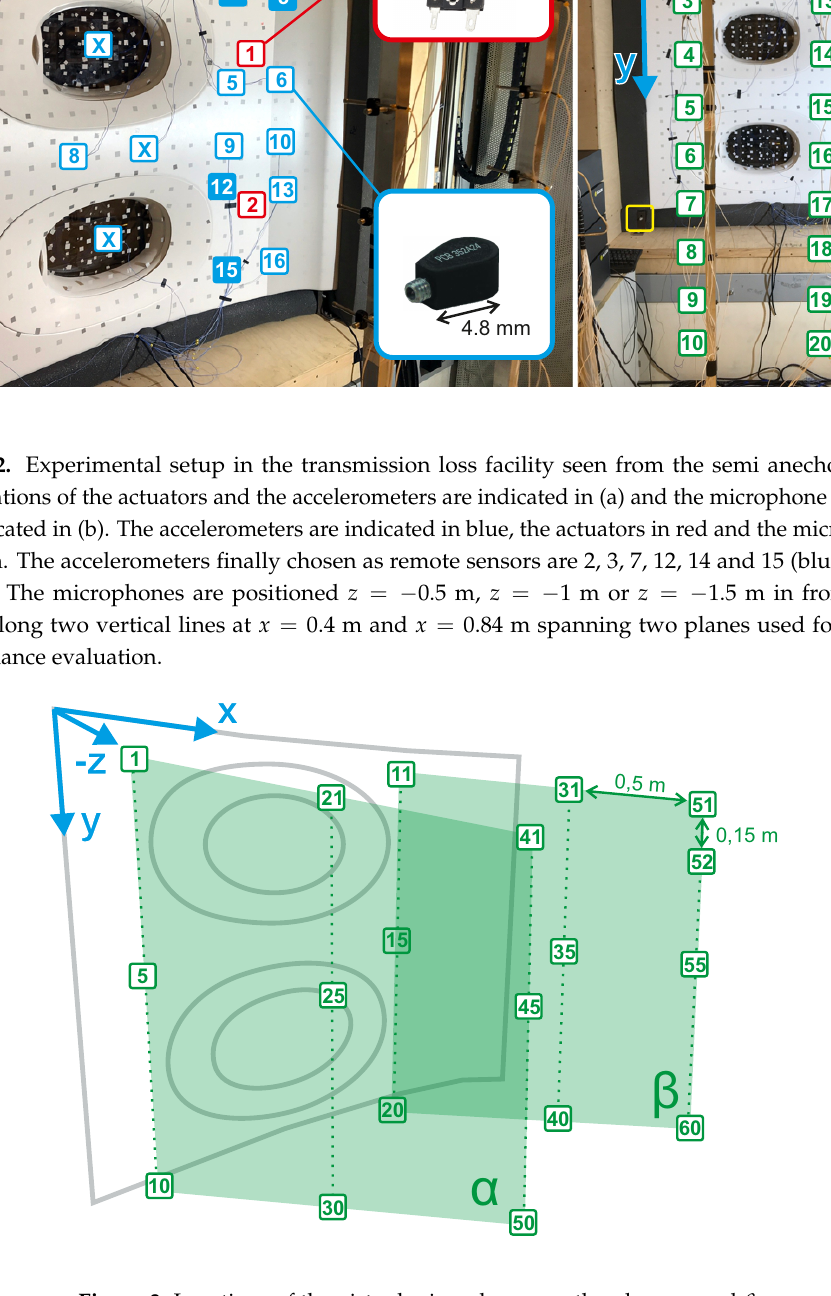
Figure 3. Locations of the virtual microphones on the planes α and β